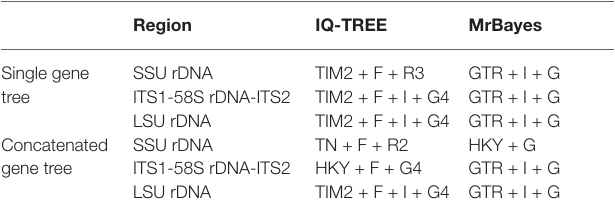
TABLE 1 | The best-fit substitution model selected for different phylogenetic